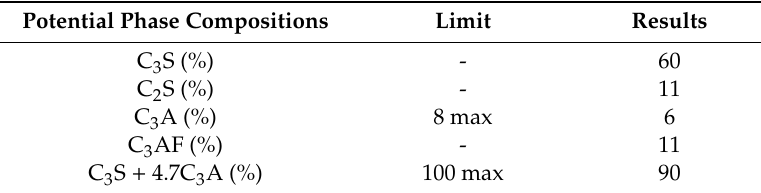
Table 3. Portland cement potential phase